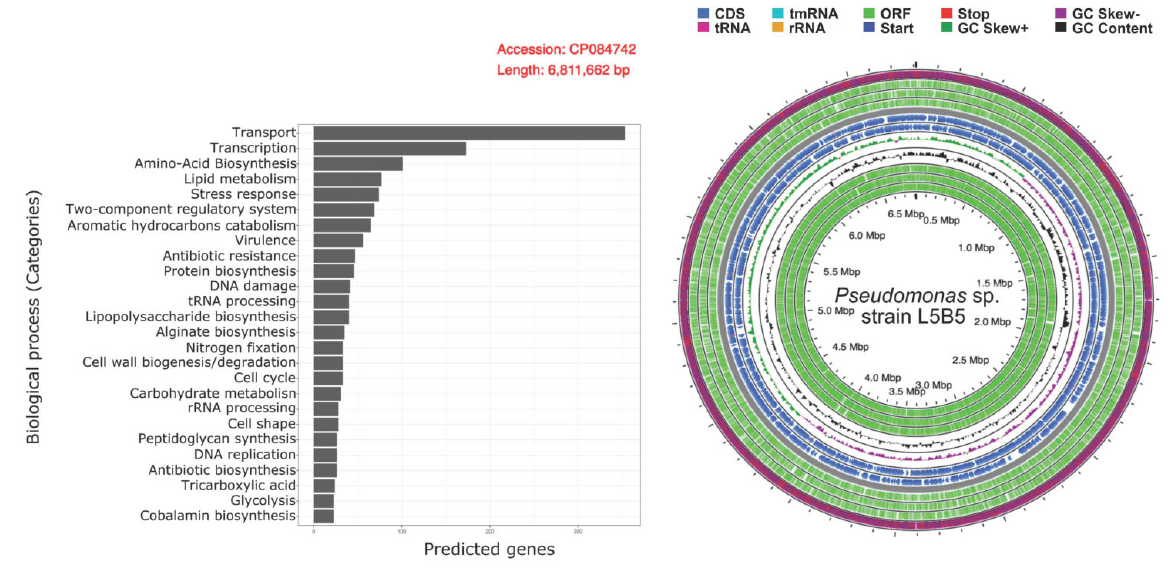
Figure 5. Biological processes annotations for Pseudomonas sp., strain L5B5 and complete genome representation.